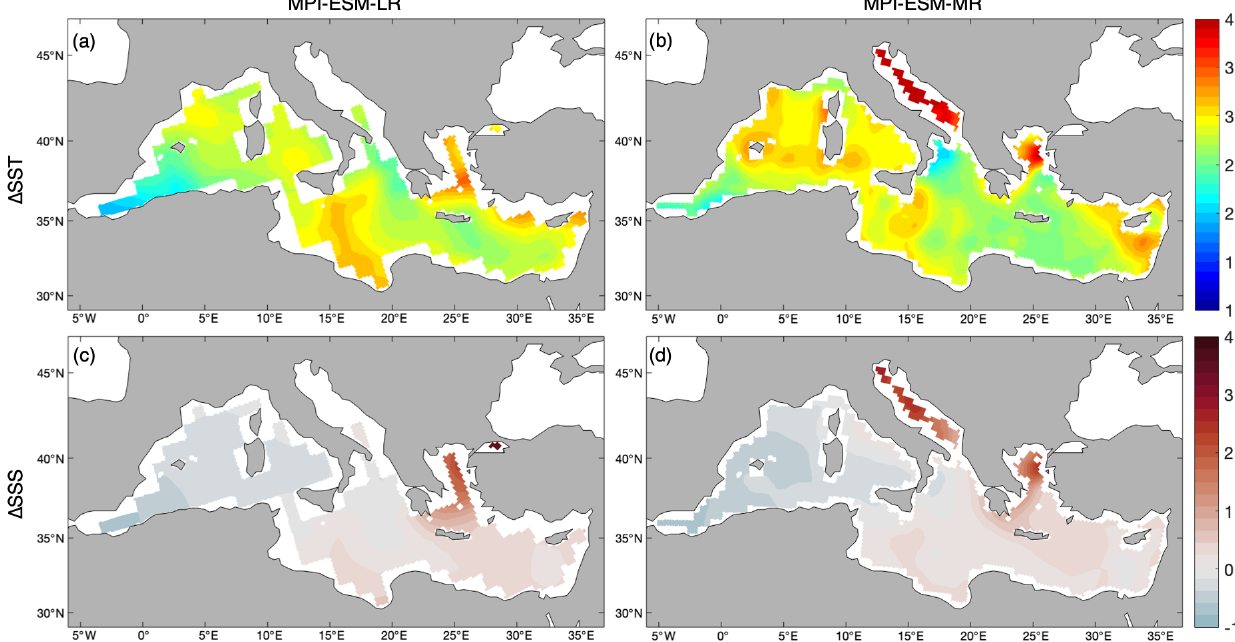
Figure 14. SST ( a, b , in ◦ C) and SSS ( c, d , in psu). MPI-ESM-LR (a, c) and MPI-ESM-MR (b, d) anomaly fields estimated as the difference between the average of the RCP8.5 projection (2070–2099) and present climate